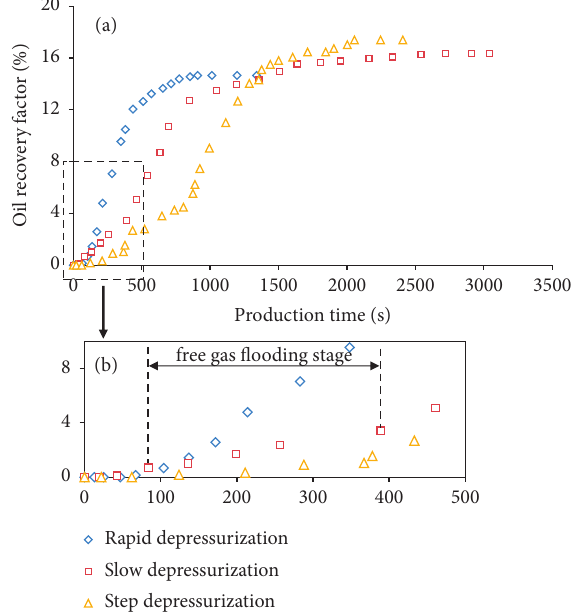
Figure 14: Oil recovery factor during puff period of the first huff- and-puff cycle with different depressurization method.